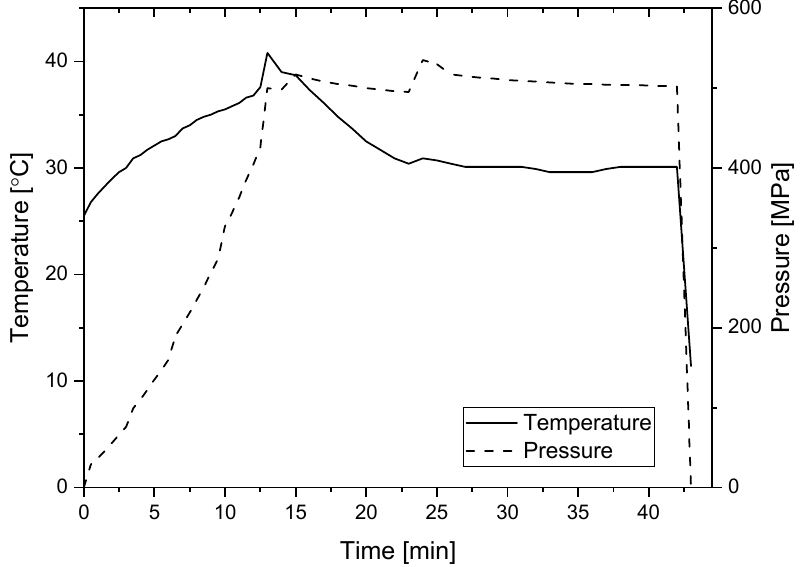
Figure 1. Representative time-temperature-pressure profile of the process used for the gelation of potato protein isolate at 500 MPa (temperature was measured at the pressurizing liquid).